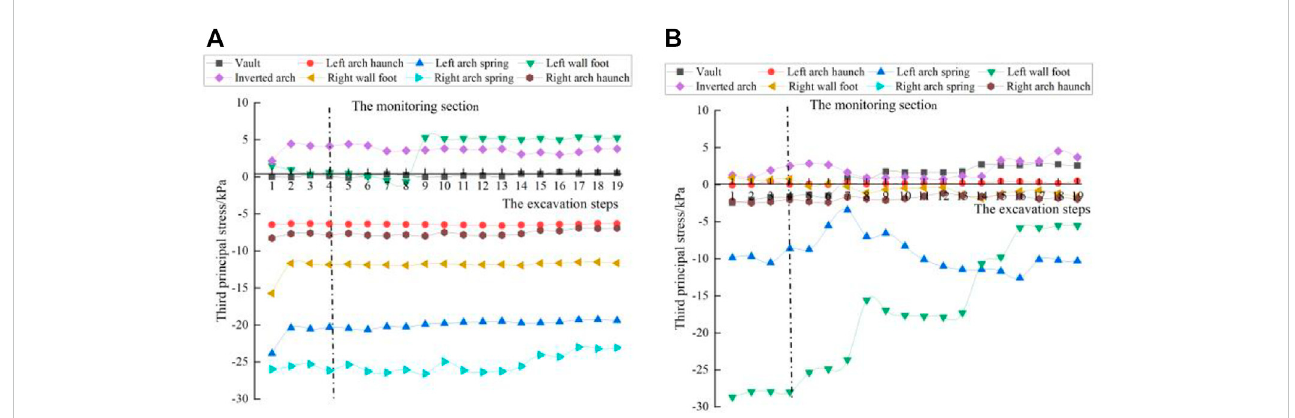
FIGURE 9 Thirdprincipalstressofliningstructure: (A) Stressatthe12-cmsectionoutsideofthestructureand (B) Stressatthe12-cmsectioninsideofthestructure.